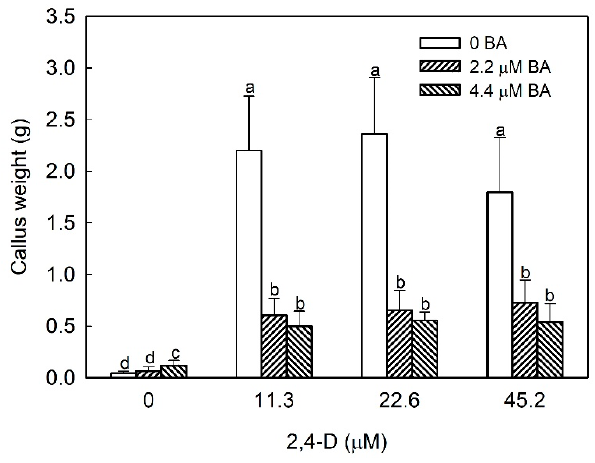
Figure 1. E ff ect of hormonal balance in callus development from strawberry leaf explants cultured in N 30 K medium. Data were taken after 8 weeks of culture in the dark. Means with di ff erent letters indicate significant di ff erences by Kruskal–Wallis test at p = 0.05.